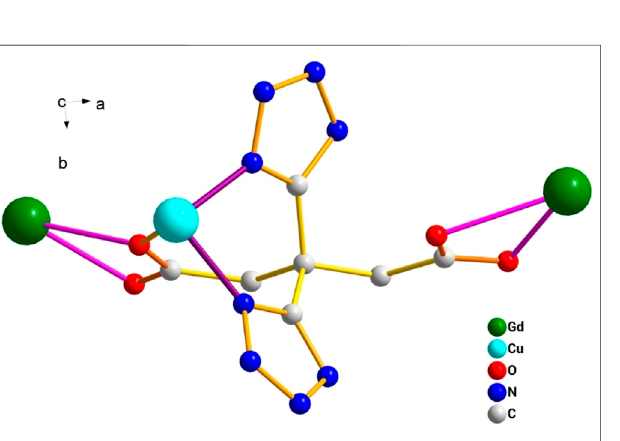
Frontiers in Chemistry |